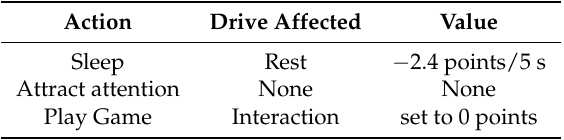
Table 3. Effect of each action over the drives of the robot.